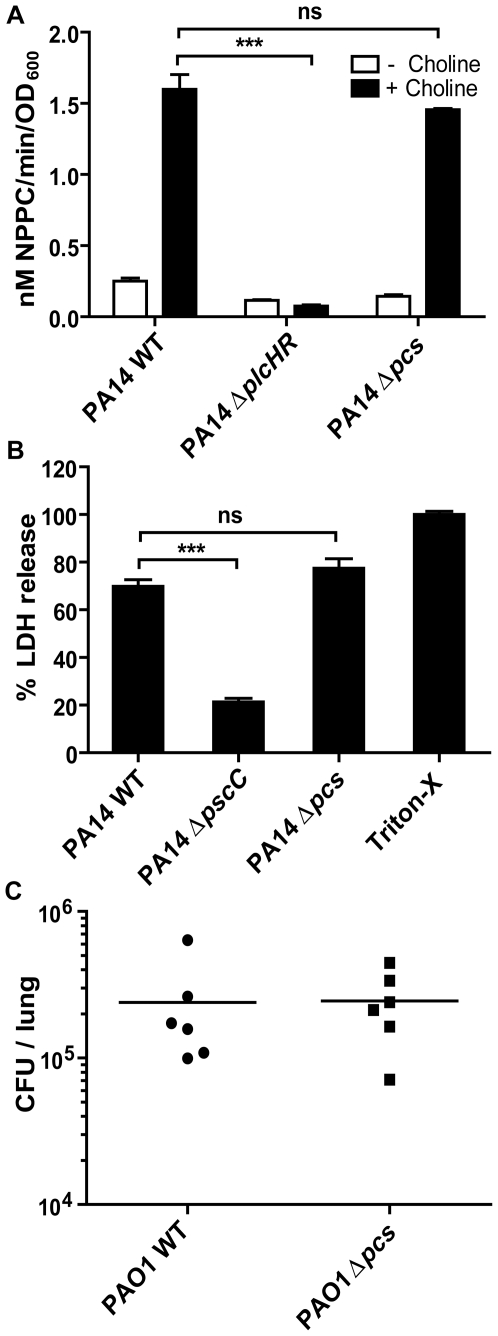
PC-deficient mutants are not defective in virulence.(A) PA14 PlcH activity was assayed for by measuring NPPC hydrolysis activity in defined medium with (black bars) or without (white bars) choline. (B) PA14 T3SS-mediated cytotoxicity towards epithelial cells was assessed by monitoring LDH release 6 hours post infection. LDH released from control cells lysed with Triton-X 100 was set as 100% cytotoxicity. In A and B, error bars represent SD of the means of triplicate experiments (C) Bacterial burden 24 hours post infection from whole homogenized lungs of mice inoculated at a high infective dose. CFU counts from individual mice are plotted with means of each group denoted by horizontal lines. Means were not significantly different. Statistical significance of data in panels A, B and C were evaluated using a two-tailed unpaired t test, ***P<0.001, ns
P>0.05.